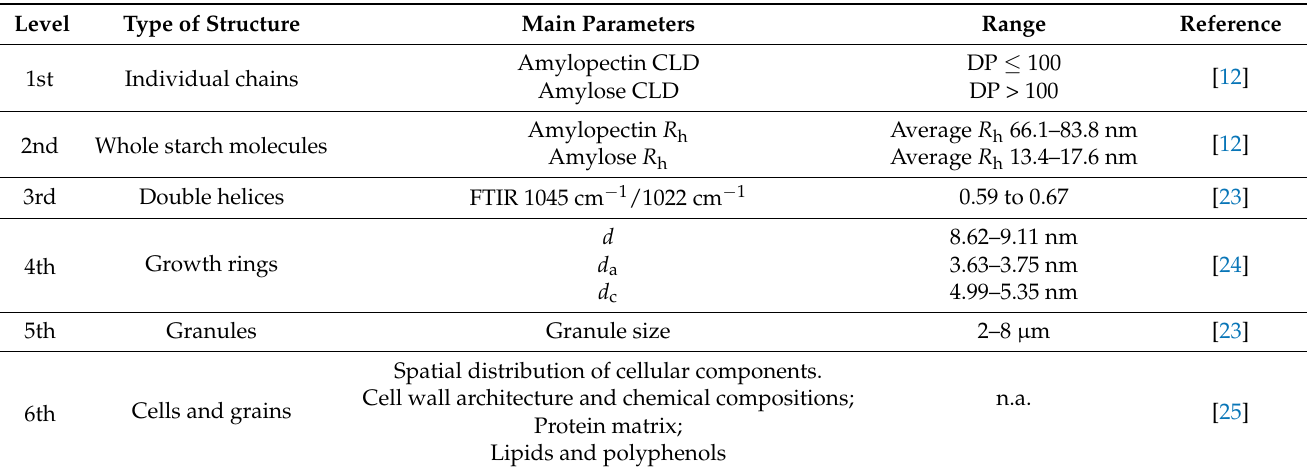
Table 1. Different levels of starch